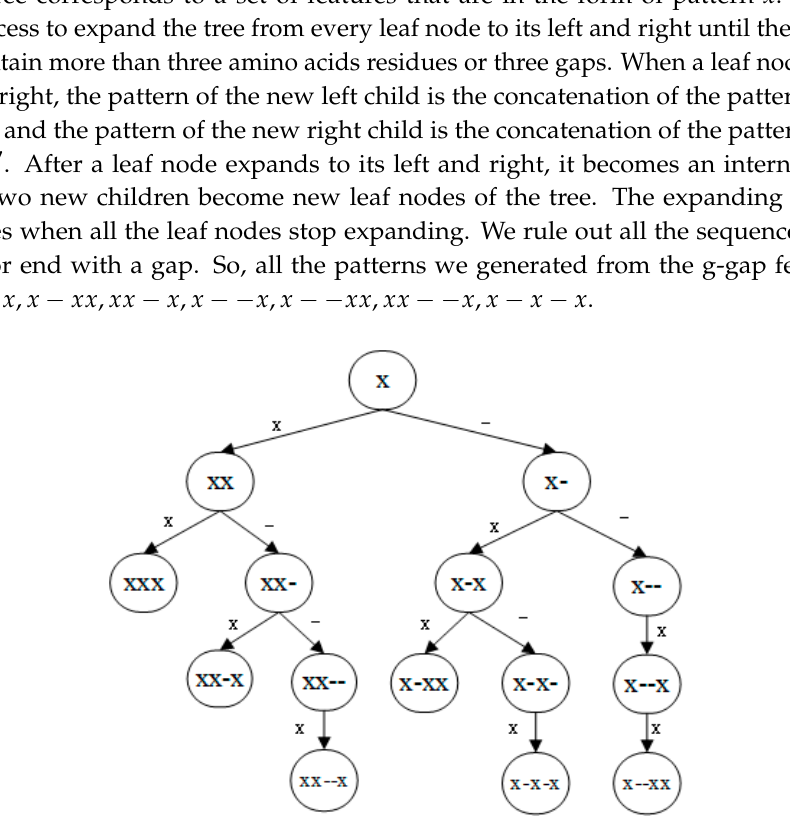
Figure 5. The g-gap feature tree.